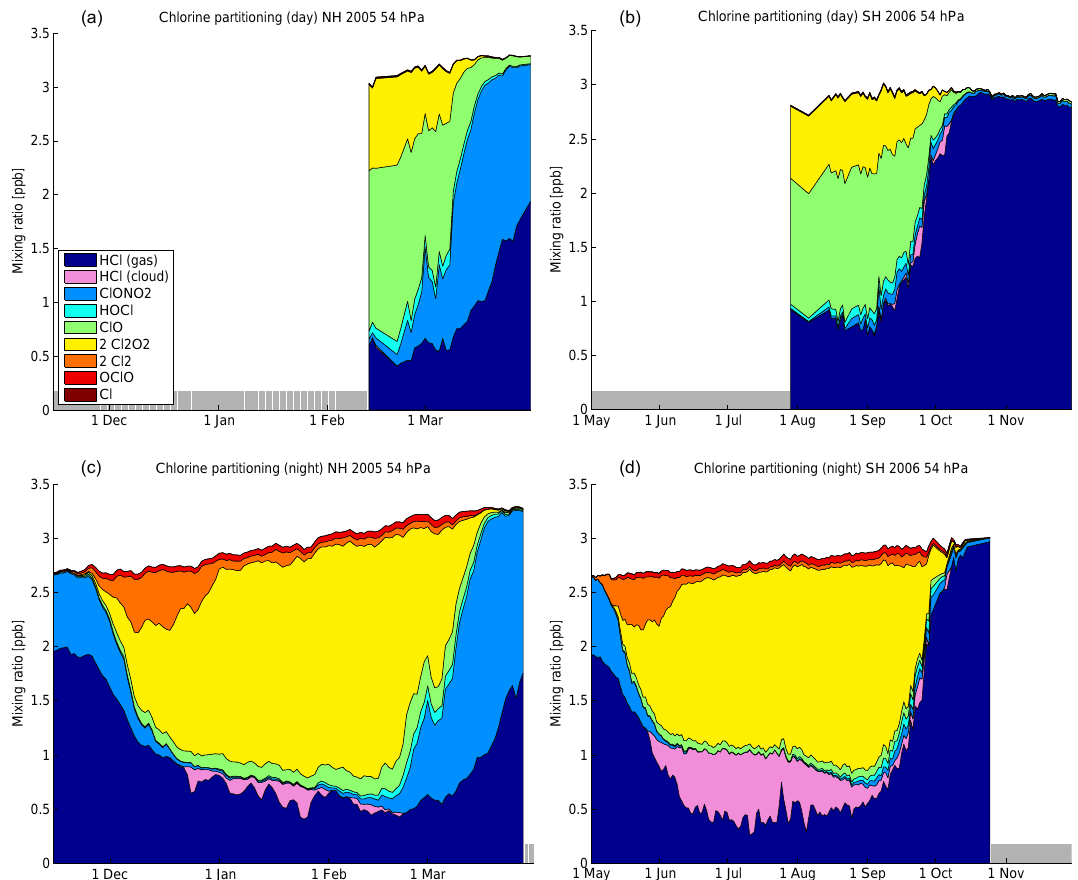
Figure 11. Vortex-averaged partitioning of inorganic chlorine species (Cl y ) for the Arctic winter 2004–2005 (a, c) and the Antarctic winter 2006 (b, d) at 54hPa. Panels (a, b) show daytime averages (parts of the vortex where the solar zenith angle is smaller than 80 ◦ ). Panels (c, d) show nighttime averages (parts of the vortex where the solar zenith angle is larger than 100 ◦ ). Days without sufficient data for averaging are not shown (grey bars). Species ClNO 2 and BrCl are not shown due to their small mixing ratios. The area labeled “HCl (cloud)” shows HCl dissolved in STS droplets due to the applied adjustment to the HCl solubility (see Sect.